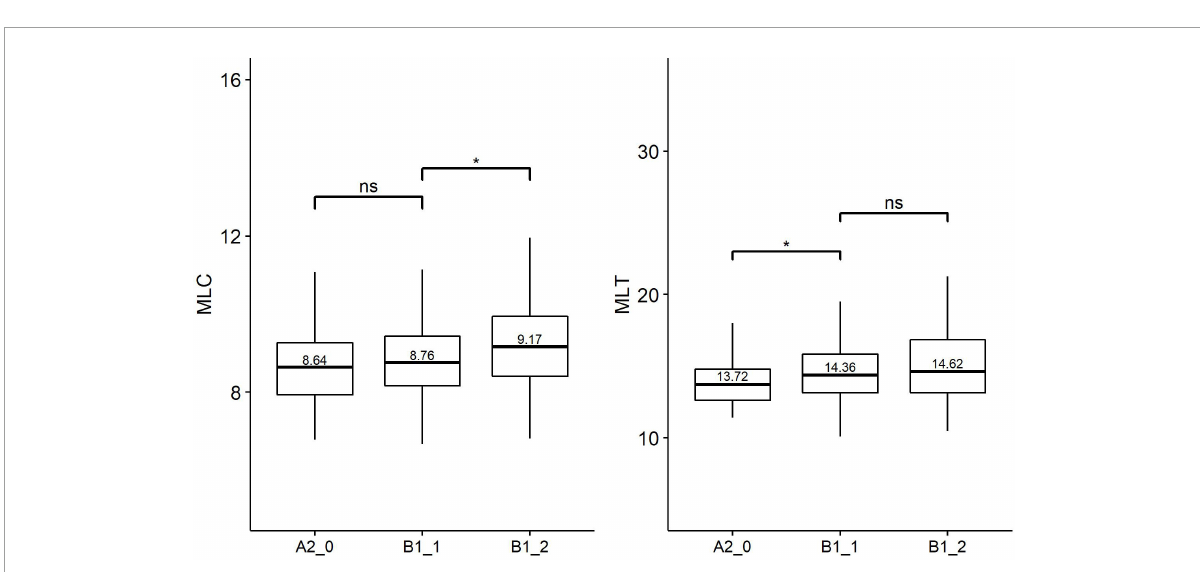
FIGURE3 Paired comparisons across learner proficiency levels on traditional syntactic complexity. * p < 0.01; ns, no significant difference.